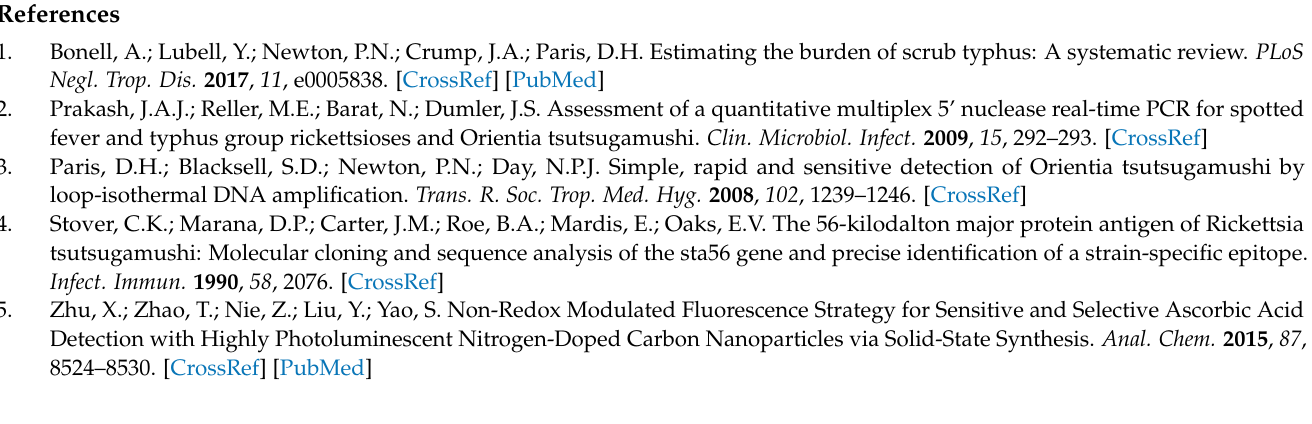
Figure S2: CV at different scanning rates of GCE (A), Au/GCE (B), and Au/NiFe-LDH/GCE (C) in 5 mM K 3 [Fe(CN) 6 ] with 0.1 M KCl, and the corresponding fitting curve of GCE, Au/GCE, and Au/NiFe-LDH/GCE (D-F); Figure S3: SWV response of MCH/P1/Au/NiFe-LDH/GCE biosensor in B-DNA with the absence (a) and presence (b) of T-DNA and only the presence of T-DNA (c). The concentration of different DNA all were 5 × 10 − 7 M. Table S1: Comparison of recently